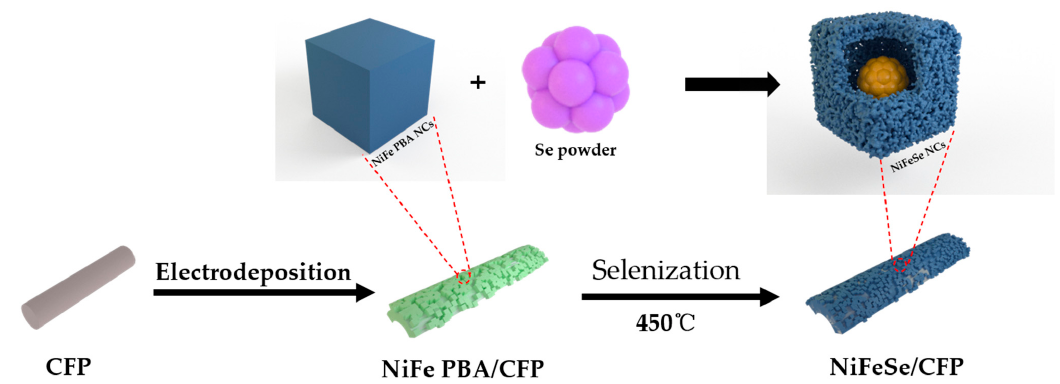
Catalysts 2022 , 12 , x FOR PEER REVIEW Figure 1. Schematic illustration of the formation process of NiFeSe/CFP. Figure 1. Schematic illustration of the formation process of NiFeSe/CFP.